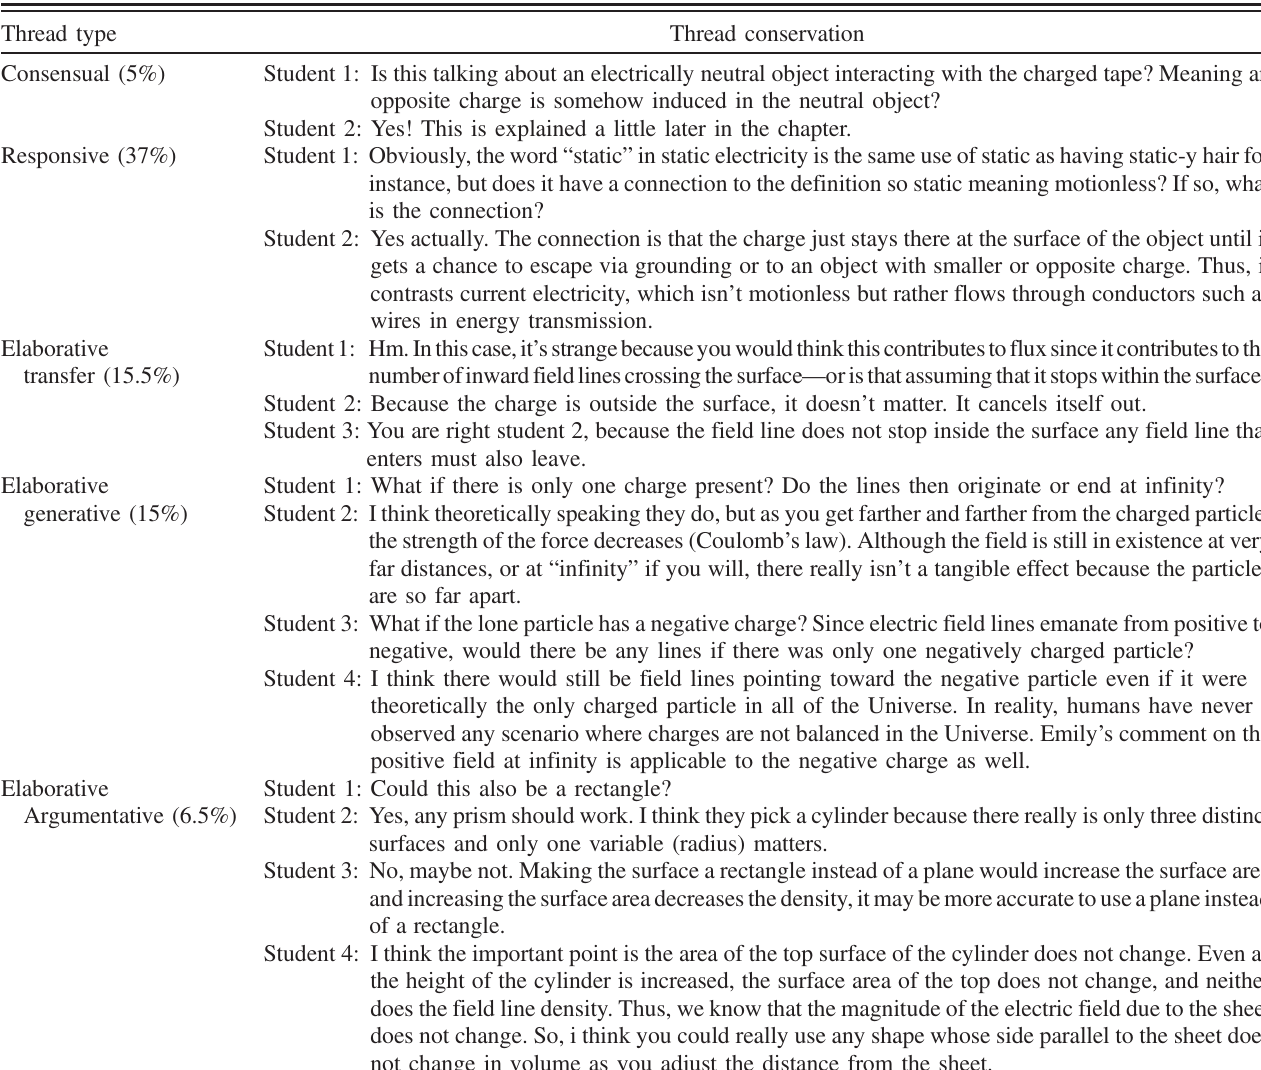
TABLE II. Examples of threads group into the five different categories. Thread type Thread conservation